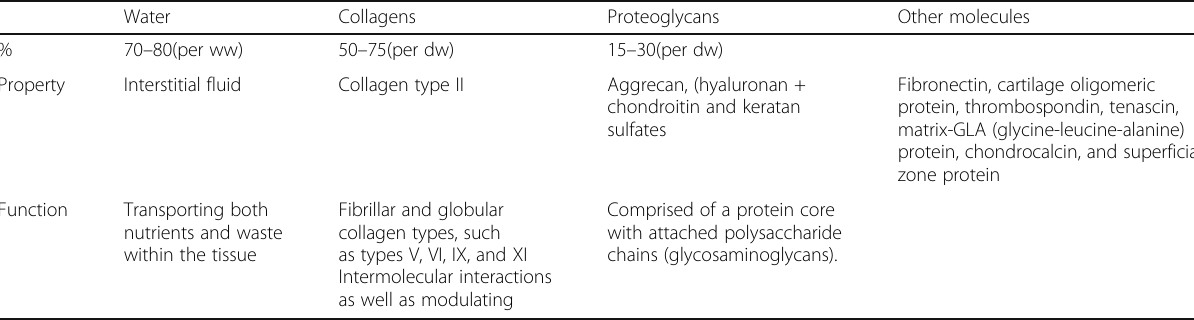
Table 1 Biochemical composition of hyaline articular cartilage [6, 7]